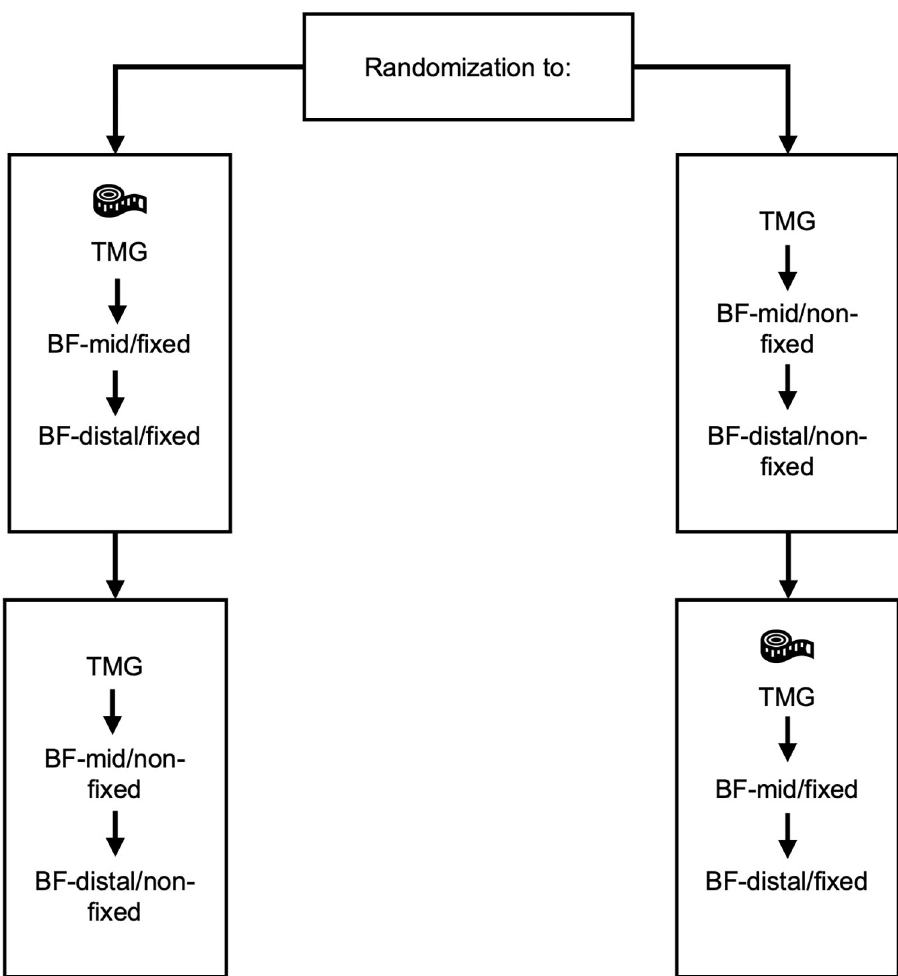
Fig 1. Schematic illustration of the measurement protocol. Participants were randomly allocated to the fixed or the non-fixed measurement condition. After completion of the protocol at both measurement sites on the m. biceps femoris (BF-mid = 50% of BF length (ischial tuberosity to fibula head); BF-distal: 5 cm distal of BF-mid), the subjects received the remaining measurement condition.